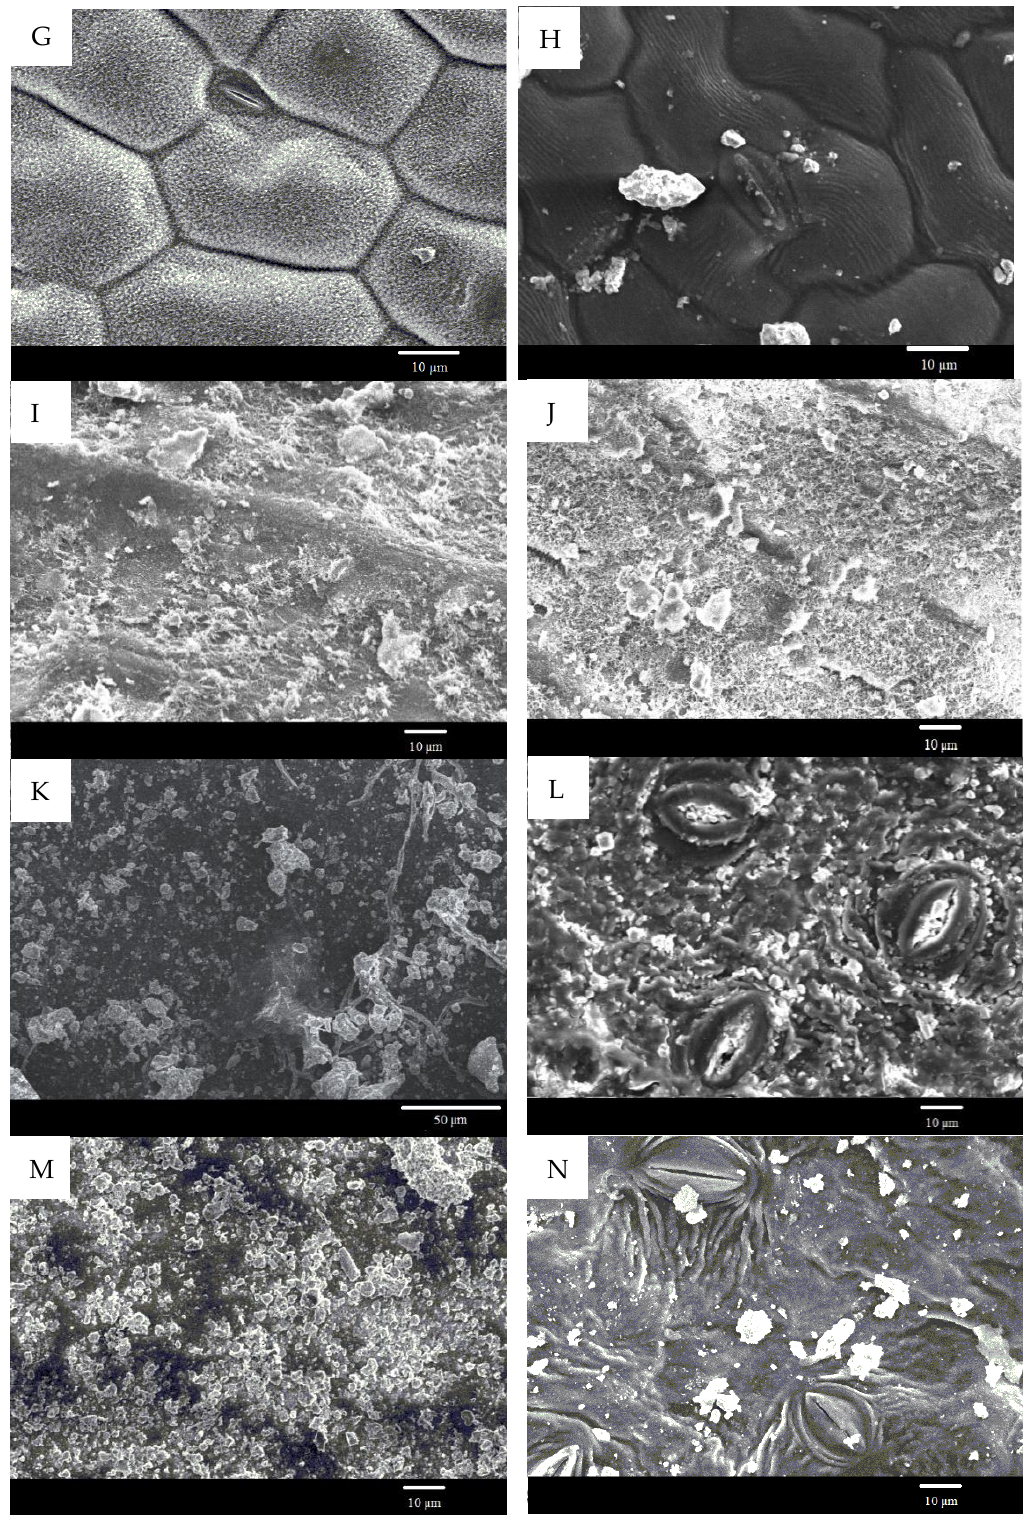
Figure 1. Scanning electron microscope pictures of Buxus sinica ( A , B ), Pinus tabuliformis ( C , D ), Pittosporum tobira ( E , F ), Trifolium repens ( G , H ), Cedrus deodara ( I , J ), Ligustrum lucidum ( K , L ) and Viburnum odoratissinum ( M , N ). Adaxial surface: A, C, E, G, I, K, and M; Abaxial surface: B, D, F, H, J, L, and N.